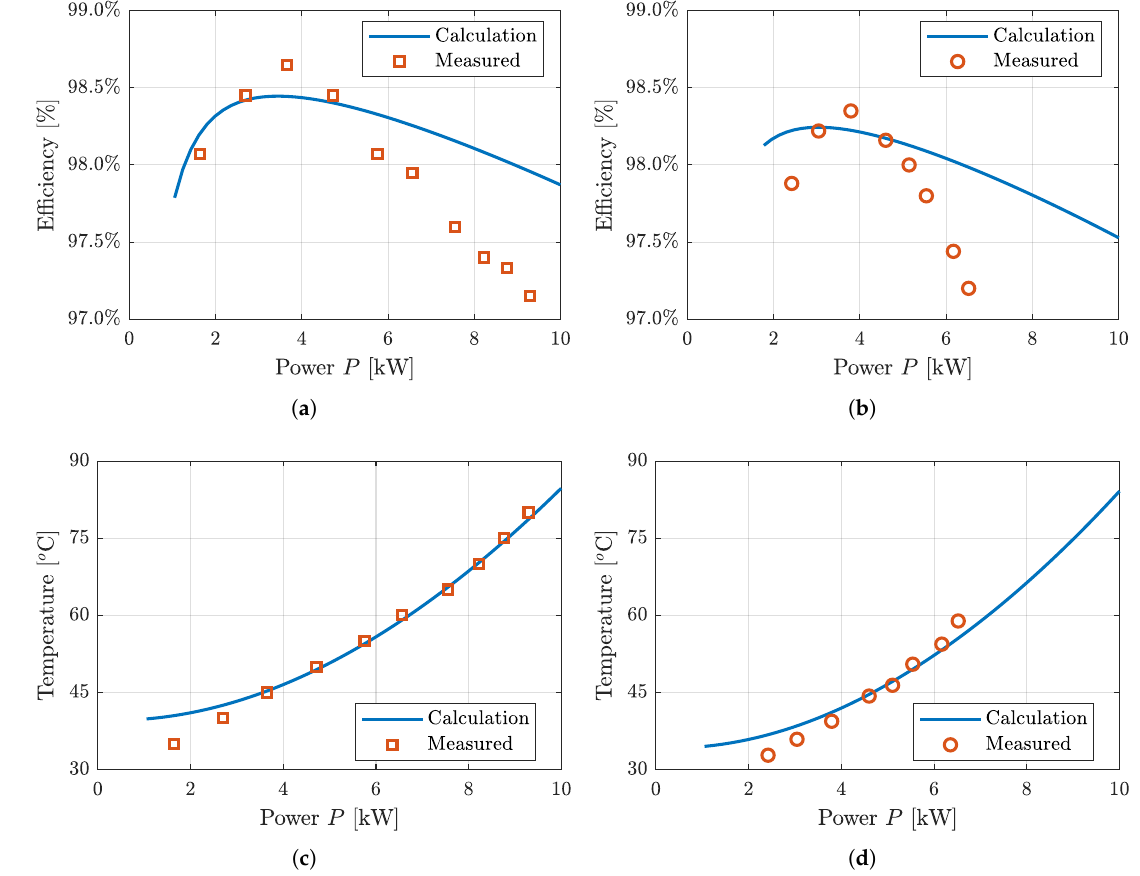
Figure 12. Performance in the soft-switching range. ( a ) Efficiency when using the optimal parameter set; ( b ) efficiency when using the competing parameter set; ( c ) temperature when using the optimal parameter set; ( d ) temperature when using the competing parameter